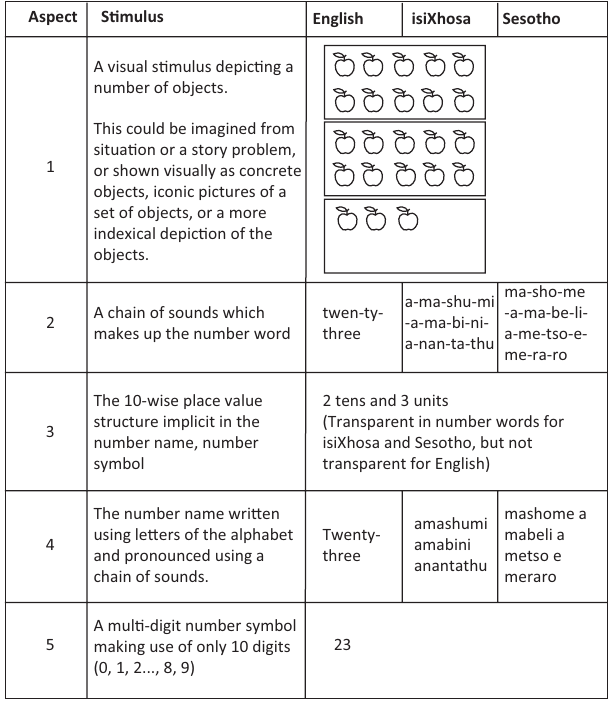
FIGURE 3: Five aspects of oral counting multi-digit numbers with